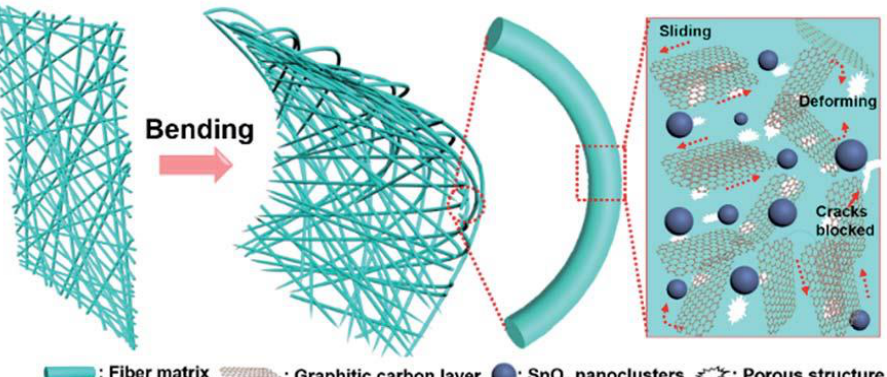
Figure 26. Schematic representation of flexibility of SnO 2 incorporated CNF membranes under bending (reproduced from the work in [78] with permission).